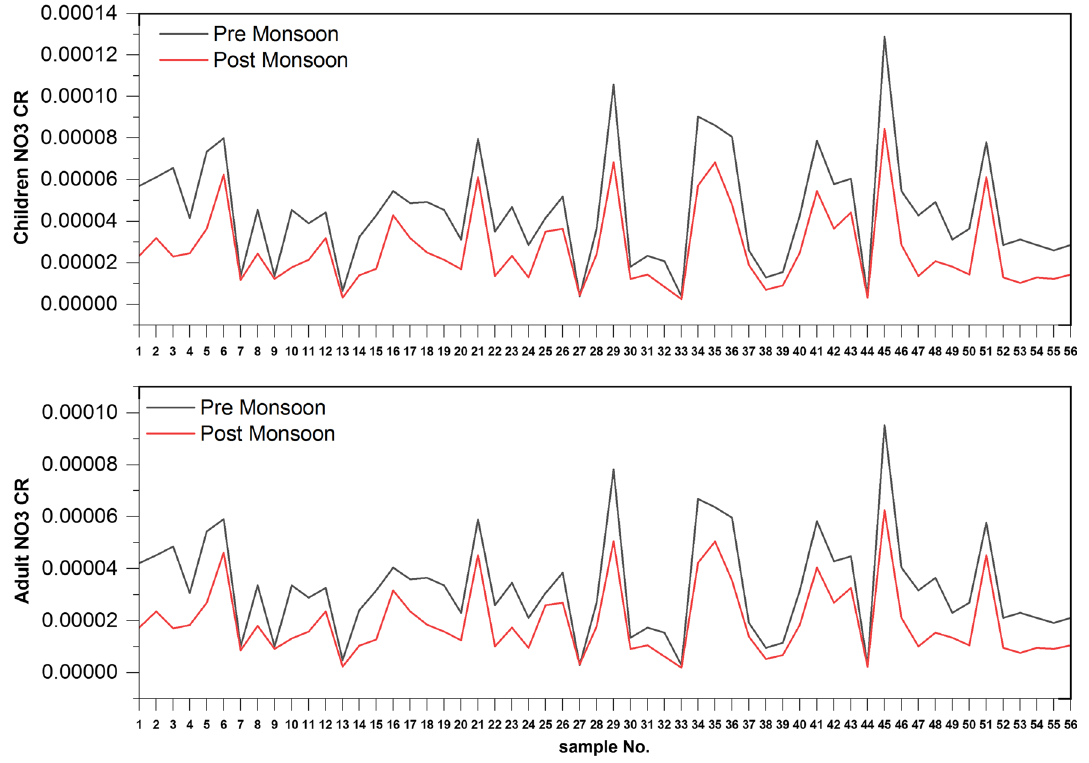
Fig. 15 Cancerous risk levels of nitrate for adults and children in pre and post-monsoon seasons of the study